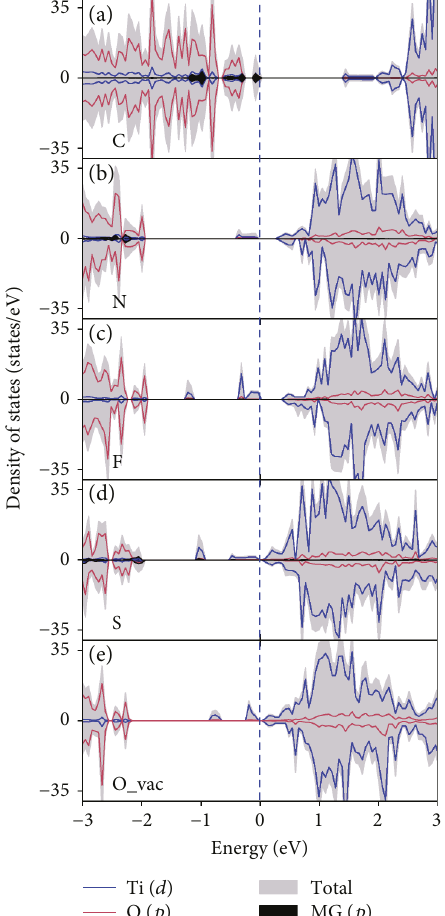
Figure 6: The total and partial density of states for pure and C-, N-, S-, F-doped anatase TiO (101) with one oxygen vacancy. Results 2 obtained with the GGAU